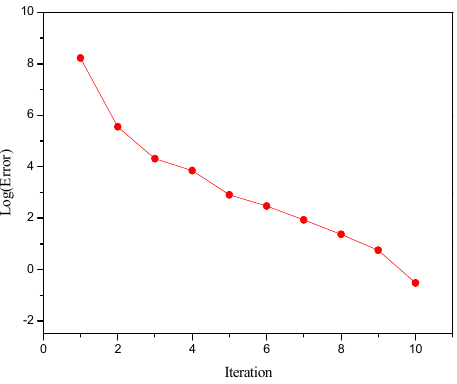
Figure 7. Error at each iteration for the simulation of isopropyl acetate reactive distillation column.